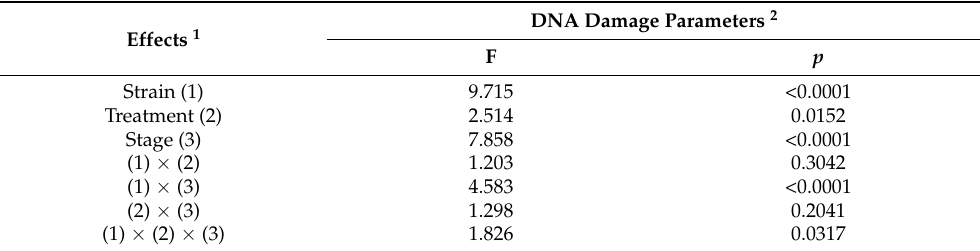
Table 1. The main effects and interactions of the factors: Strain, Treatment, and Stage on DNA damage parameters in the cells of Acheta domesticus .